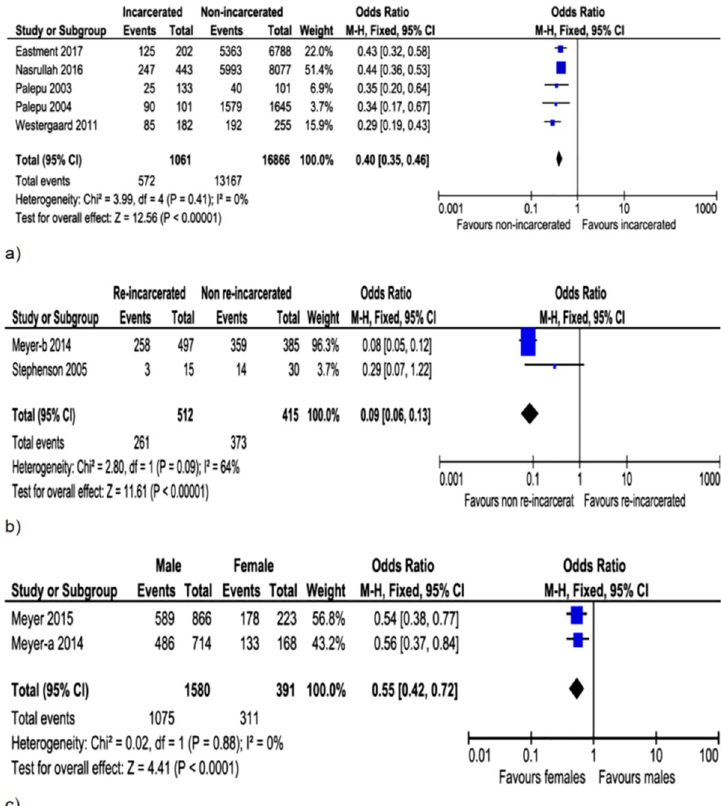
Fig 4. Forest plot of associations between viral suppression and incarceration (a), re-incarceration (b) and gender (c). Incarcerated people were at higher risk of viral non-suppression compared to unincarcerated people but had lower risk than re-incarcerated people. Higher odds of viral suppression in females than males at exit from prison.